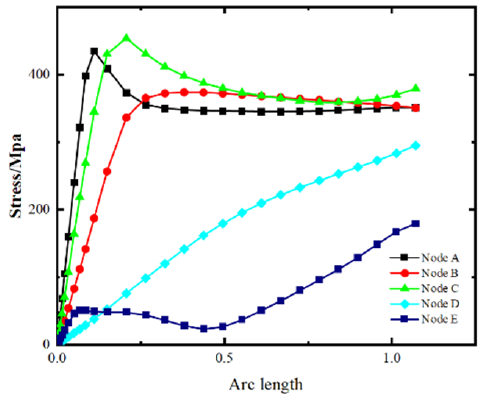
Figure 16. Stress curves of nodes A to E.